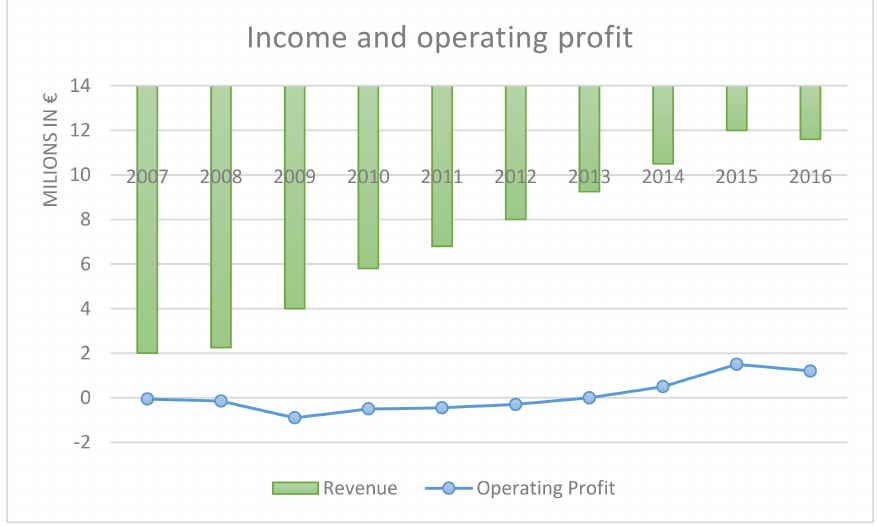
Figure 6. Income and operating profit after the start of digitalisation in an automotive